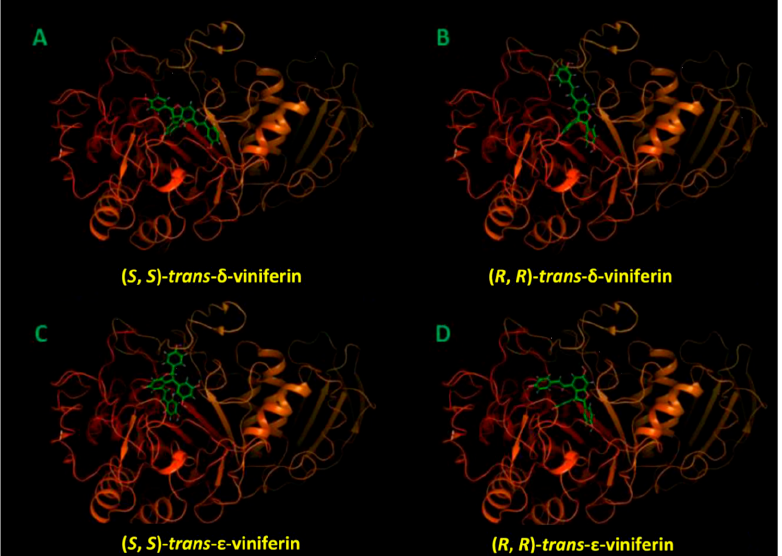
Figure 8. Top-scoring binding poses between the pig pancreatic α -amylase and the enantiomeric forms of the trans -viniferin species in the protein active site: A, ( S , S )- trans - δ -viniferin; B, ( R , R )- trans - δ -viniferin; C, ( S , S )- trans - ε -viniferin; D, ( R , R )- trans - ε -viniferin.